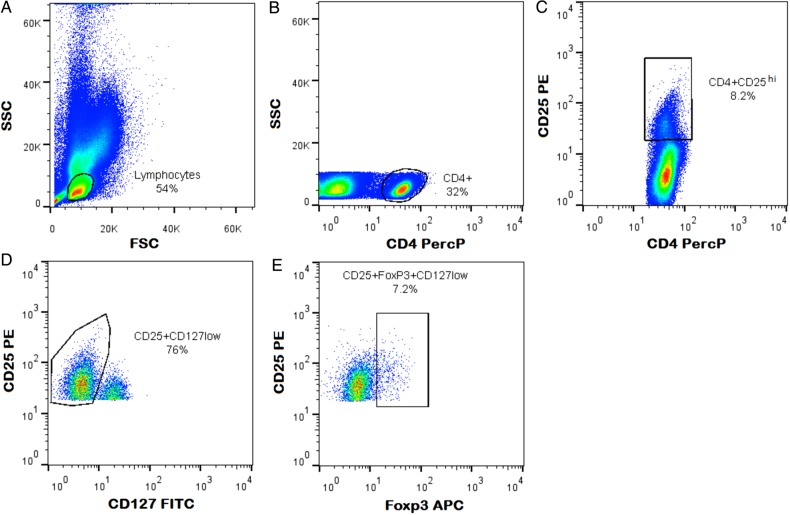
Gating strategy for CD4+CD25hiFoxP3+CD127low regulatory T cells that was used in this study. FITC, fluorescein isothiocyanate; PercP, peridinin chlorophyll protein.